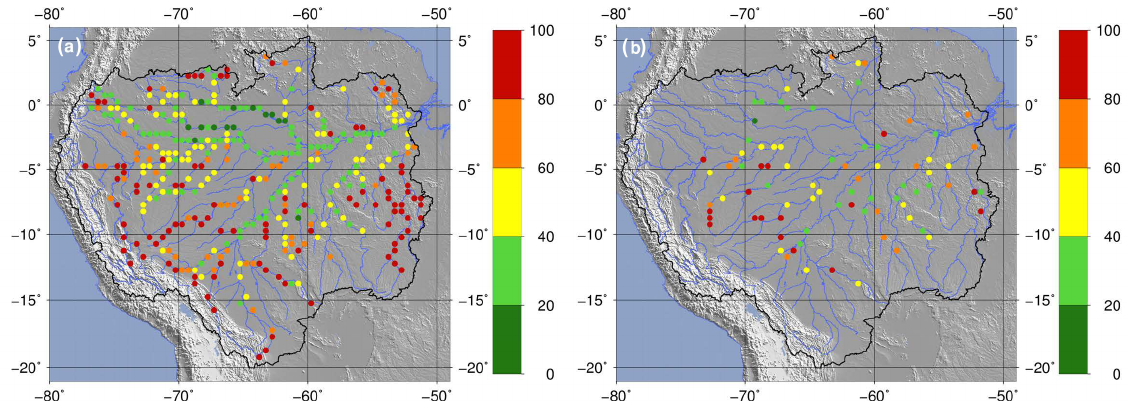
Figure 6. RMSEn for the free run simulation compared to the ENVISAT discharges (a) and the gauge discharges (b) .